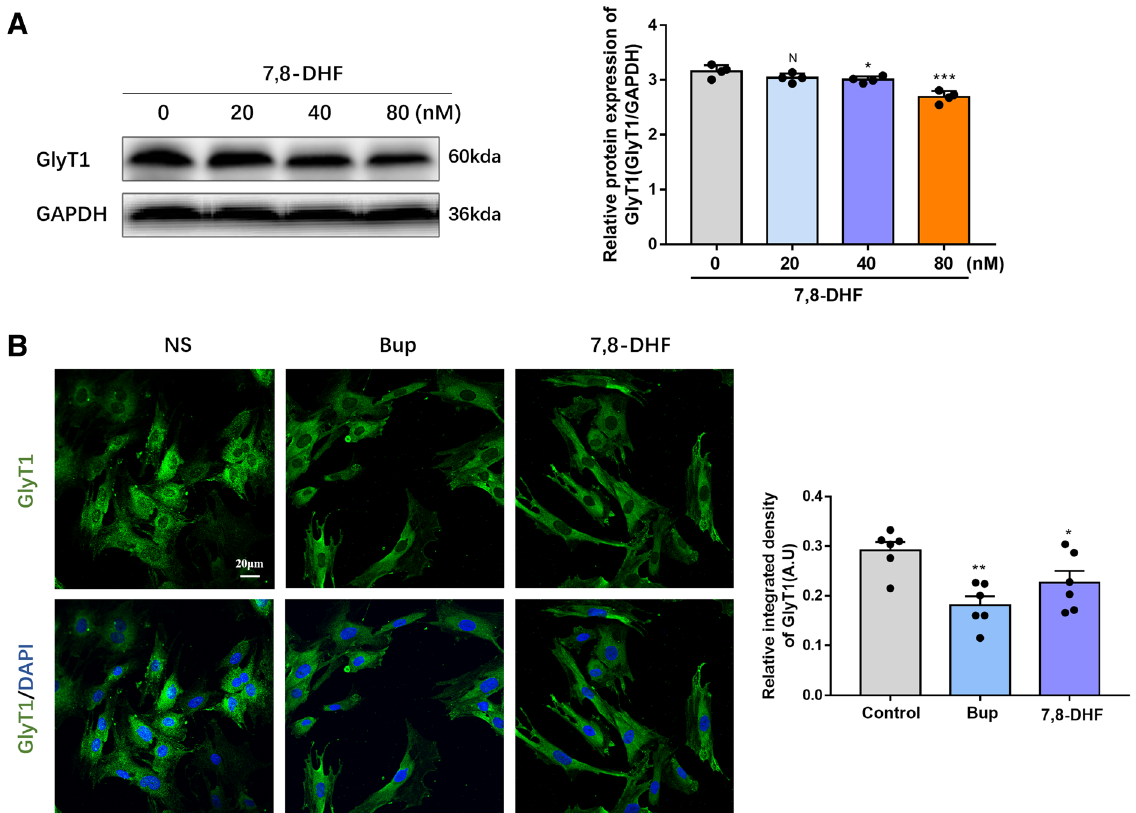
Figure 2. Effects of 7,8-DHF (BDNF receptor agonist) on GlyT1 in astrocytes. ( A ) Protein expression of GlyT1 in astrocytes after treatment with 7,8-DHF was measured by western blotting. ( B ) Representative image and fluorescence intensity quantification of the GlyT1 expression using immunofluorescence staining. * p < 0.05, ** p < 0.01, *** p < 0.001 vs. the control group. Data are expressed as the mean ± SEM. Original images of gels/blots are available in Supplementary Fig